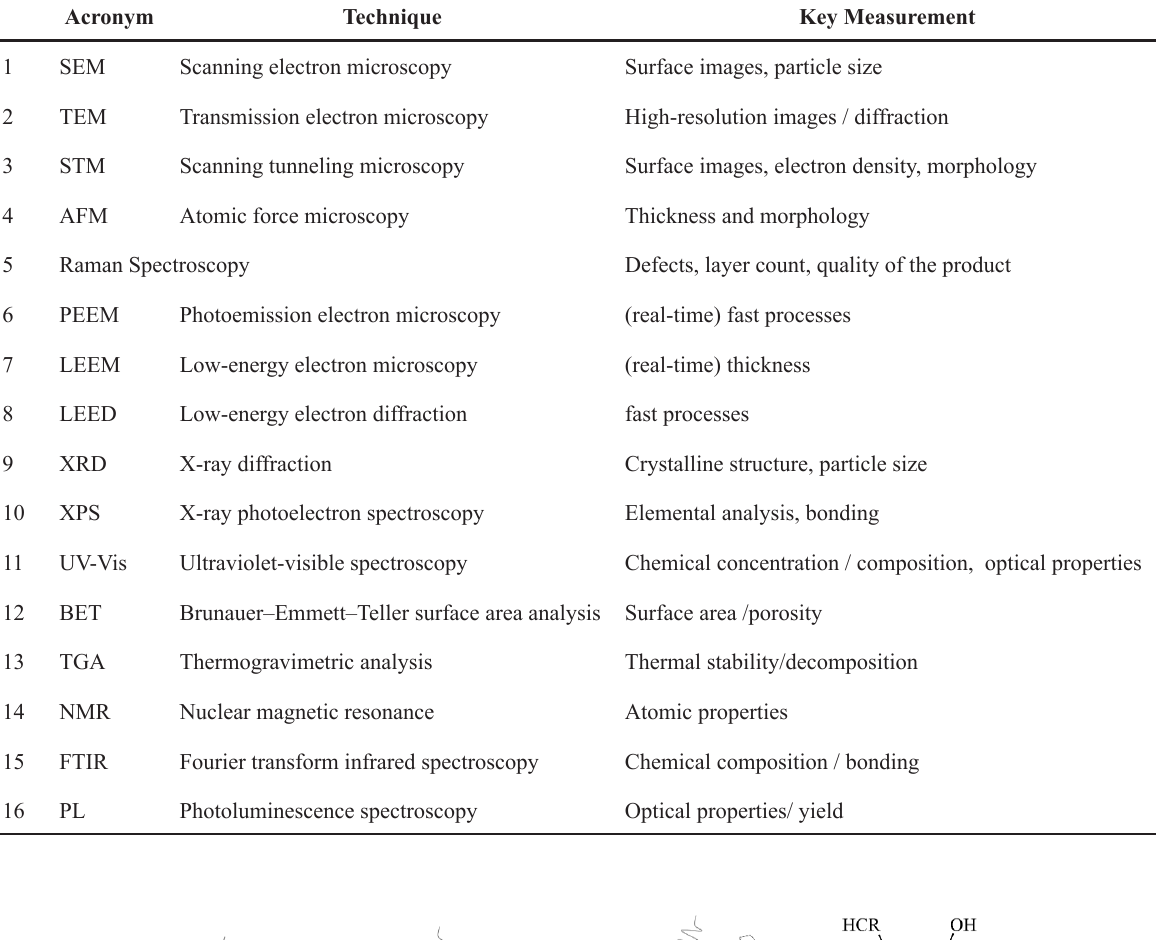
Table 1: Experimental techniques for Graphene and GQD characterization (Zhang et al., 2019).